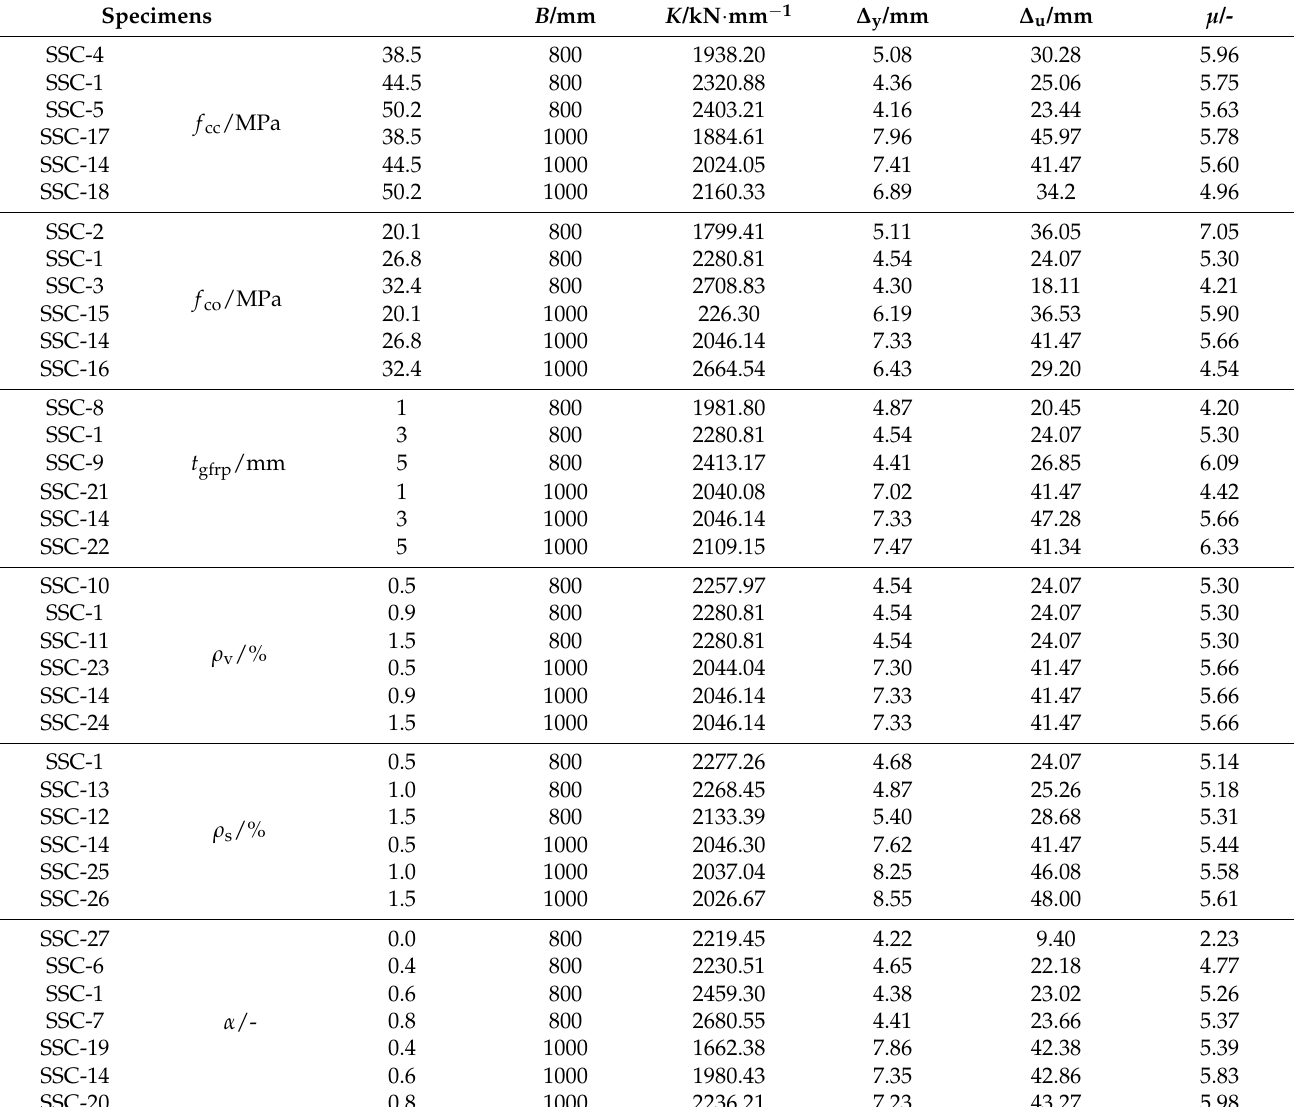
Table 5. K and µ of EGCSSCs with different